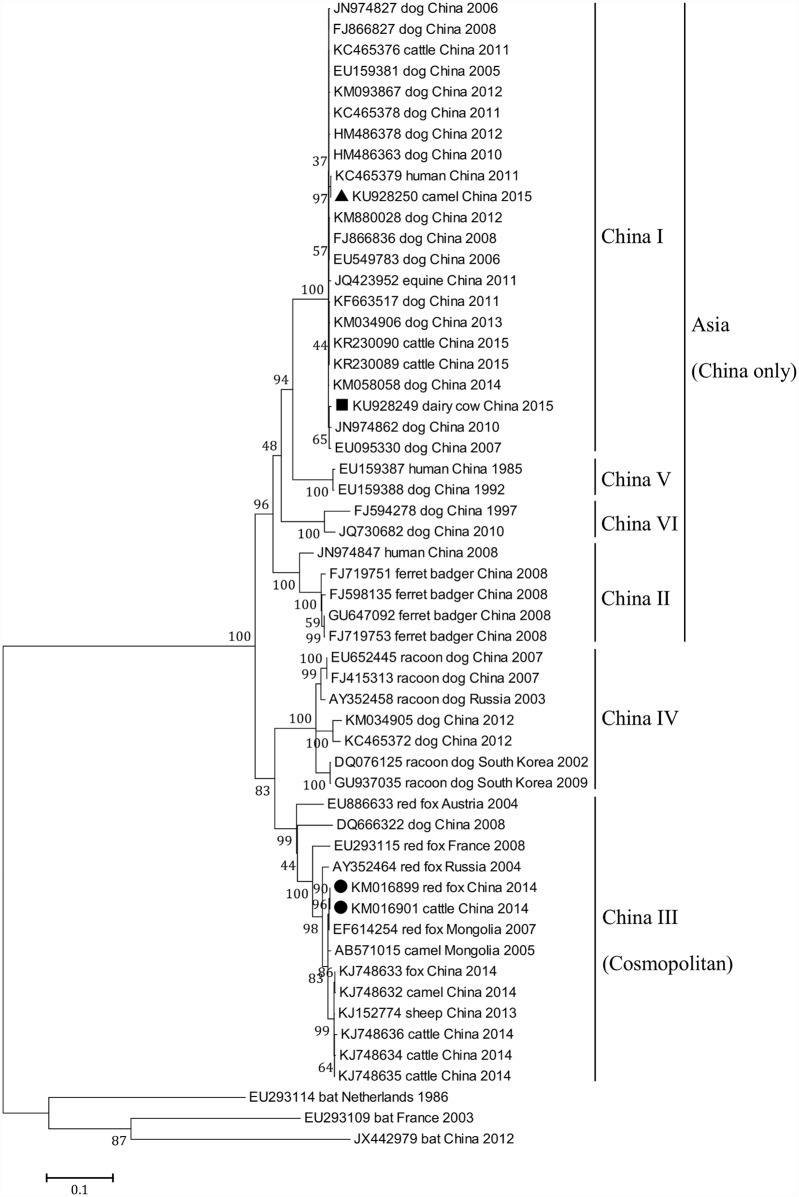
Maximum likelihood phylogenetic tree based on the complete rabies virus nucleoprotein gene.The tree is rooted with Irkut virus isolate JX442979, European bat lyssavirus type 1 and 2 isolates EU293109 and Eu293114. The RABV isolates in this study are marked using black triangles, black squares and black circles.